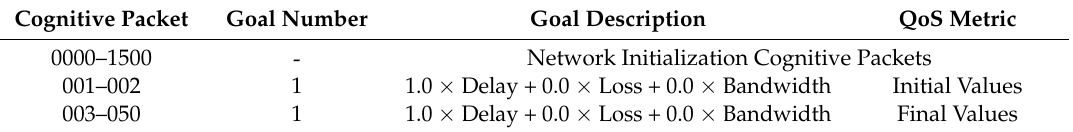
Table 15. QoS Deep Learning Cluster Validation—Simulation Parameters (5 × 5 Nodes).